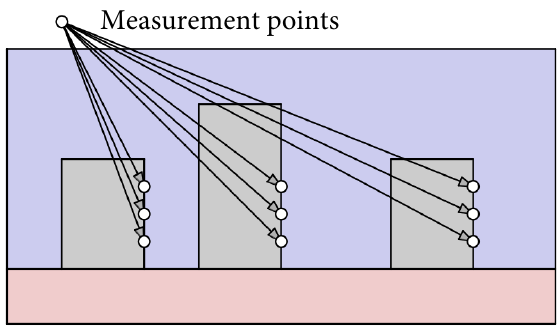
Figure 5. Measurement points in each building (1, 2 and 3 m from the